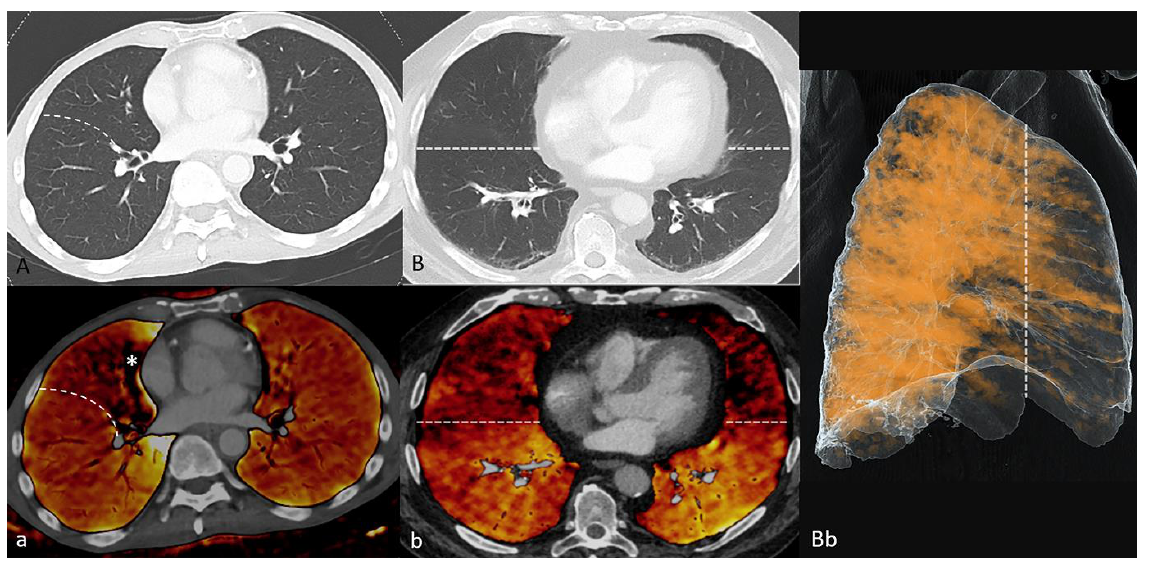
Figure 7. Examples of pathological findings in the perfusion blood volume (PBV) images ( a , b ) without anatomic correlates ( A , B ): ( A / a )—50-year-old male patient from the study group (vDE—portal-venous thoraco-abdominal Dual Energy CT). An area of reduced PBV, limited to the middle lobe (oblique fissure: dashed white line), can be differentiated from a small rotation artifact around the heart (asterisk). ( B / b / Bb ) 79-year-old male patient from the reference group (aDE—pulmonary arterial Dual Energy CT). The PBV is reduced in the anterior parts of both lungs (in front of the dashed white line), without respecting fissural borders (anteroposterior gravity gradient).